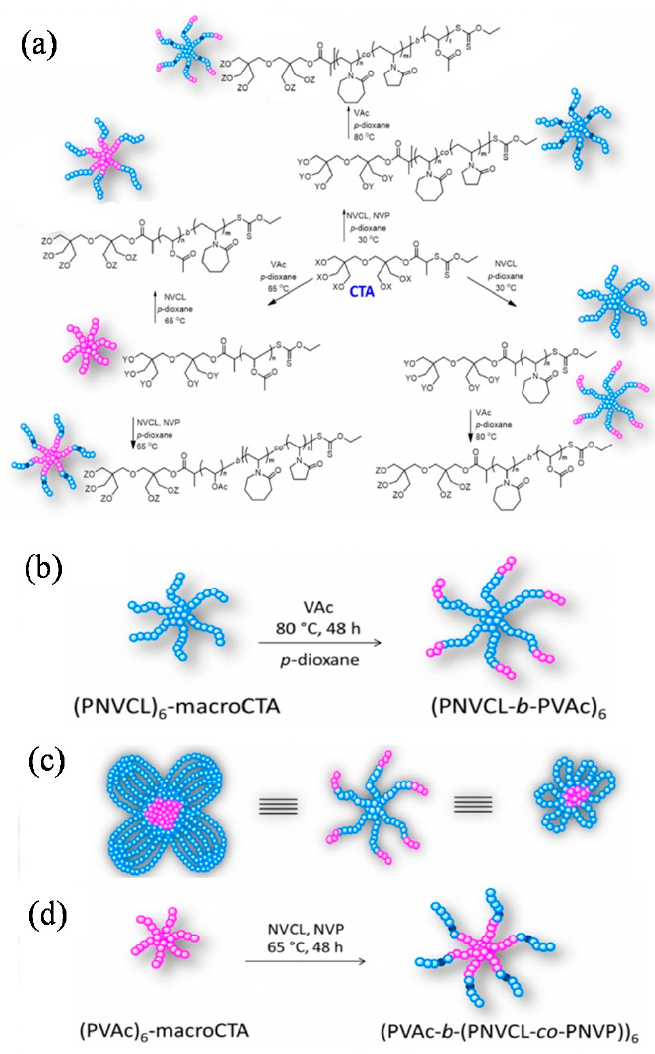
Figure 4. ( a ) Synthesis of hexafunctional star polymers and block copolymers based on PNVCL using amultifunctional xanthate as a RAFT agent; ( b ) Synthesis of star (PNVCL- b -PVAc) 6 copolymers; ( c ) Self-assembly in aqueous solution of star (PNVCL- b -PVAc) 6 block copolymers; ( d ) Synthesis of the star [PVAc- b -(PNVCL- co -PNVP)] 6 block copolymers. The blue and red colors represent PNVCL and PVAc, respectively. Copyright 2017,